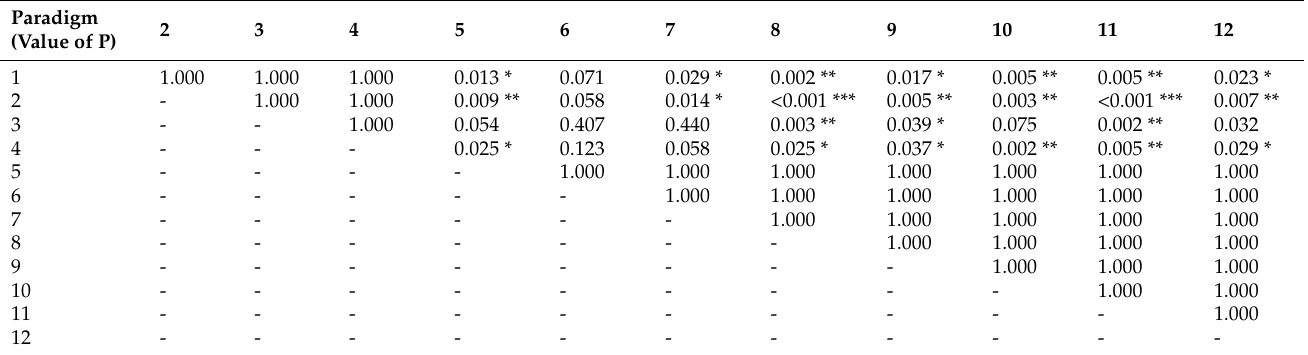
Table A1. Bonferroni Post-Hoc Analysis of the First Three Trials of Pupil Diameter among Twelve